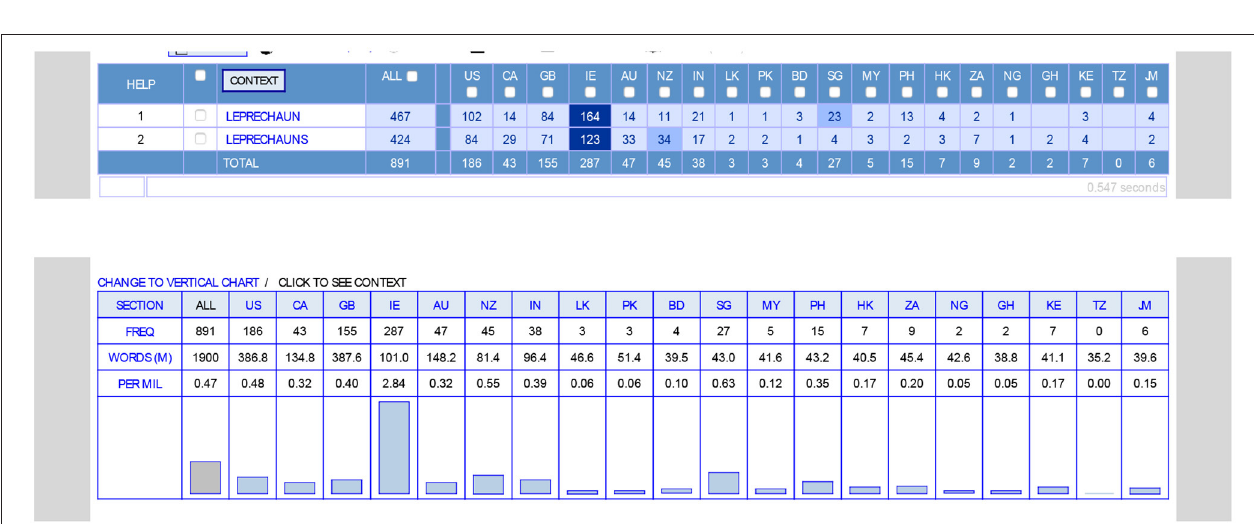
FIGURE 17 | Distribution of leprechaun in the GloWbE Corpus (from https://www.english-corpora.org/glowbe/).